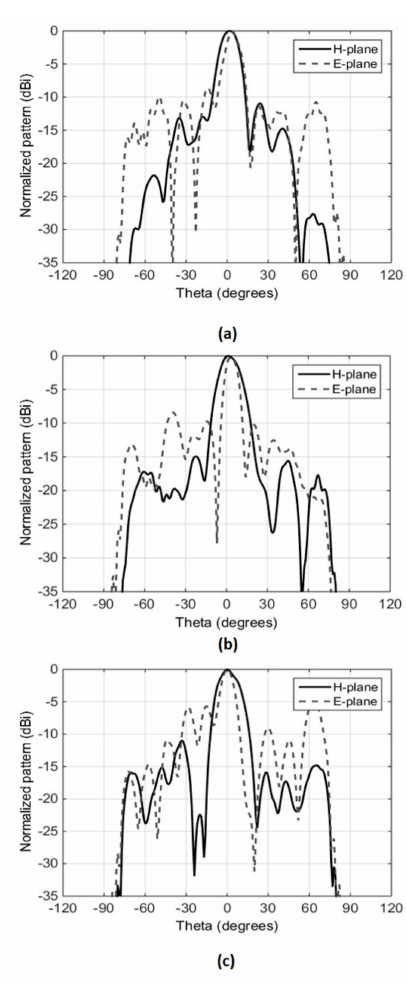
Figure 9. Radiation patterns of the RCA with planar feed measured at Australian Antenna Measurement Facility (AusAMF), ( a ) 12.8 GHz, ( b ) 15.0 GHz, ( c ) 16.0